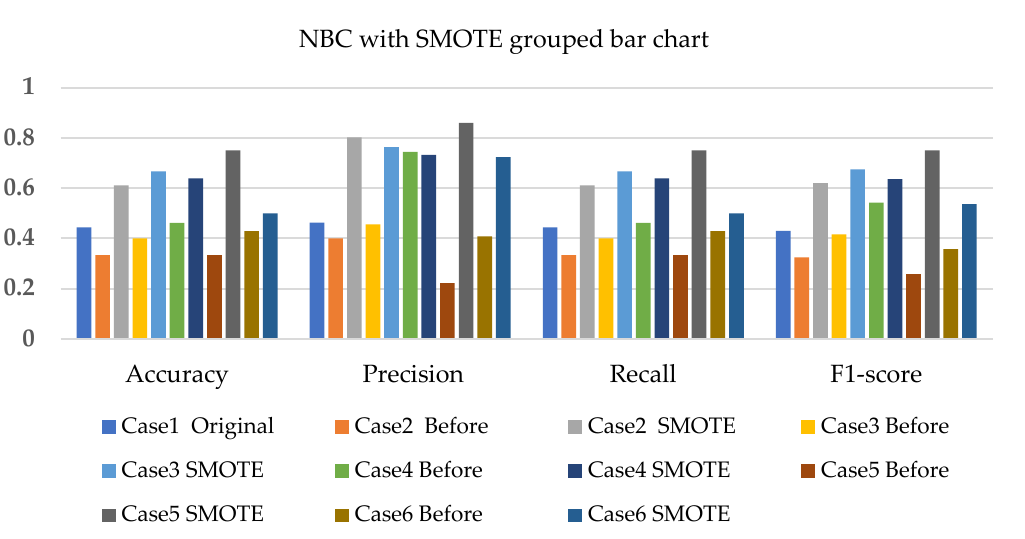
15 of 22 Figure 13. Simulation performance of k-NN classification with SMOTE/T-link. 4.2. Experimental Analysis Based on the various cases with the split of 20% test experimental data. Figures 14– 16 present the weighted average performances of NBC with SMOTE, NBC with T-link, and NBC with SMOTE/T-link. The NBC with SMOTE presents case 5 with the best per- formance of 0.75—accuracy and recall; 0.86—precision; and 0.751—F1-score. The lowest performance is presented in case 6. The NBC with SMOTE has a minimum accuracy of